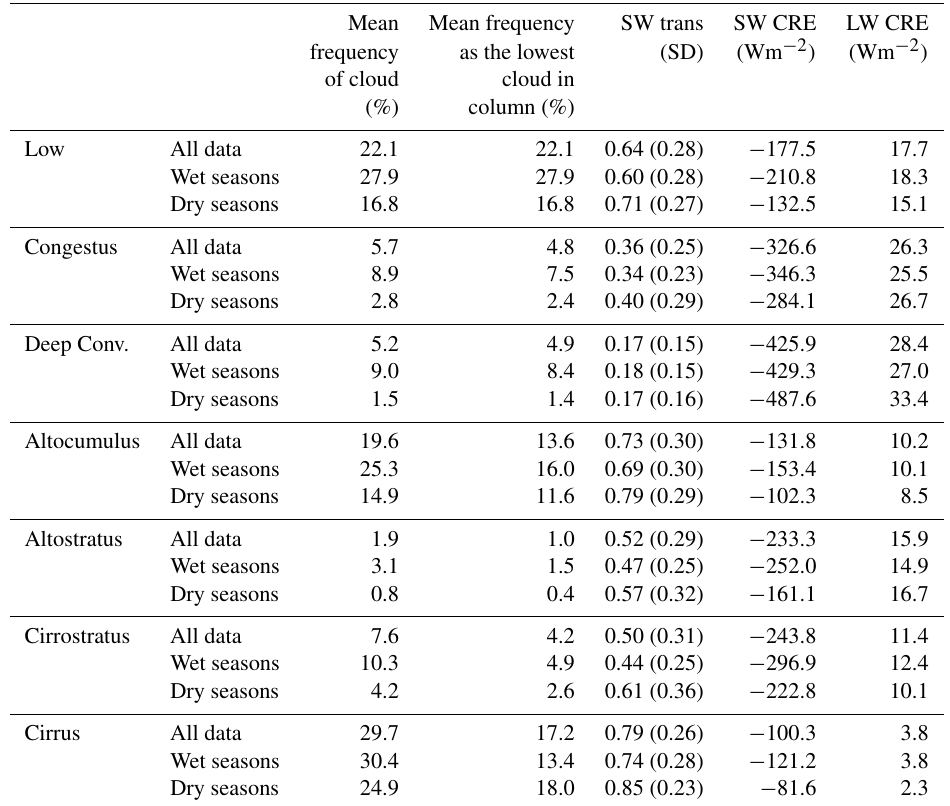
Table 2. Frequencies of cloud occurrence in the column and associated conditional shortwave (SW) transmissivity (SW trans), conditional SW cloud radiative effect (SW CRE) and conditional longwave (LW) cloud radiative effect (LW CRE) for each cloud type. All values are averaged across the diurnal cycle. For SW CRE, only daytime hours are included. SW transmissivity values in parentheses are standard deviations